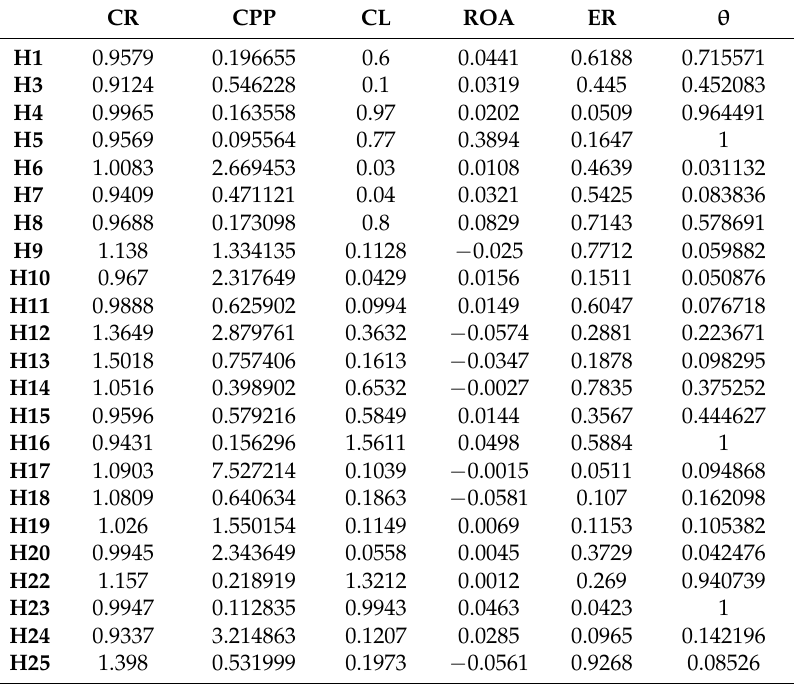
Table 8. Results of DEA